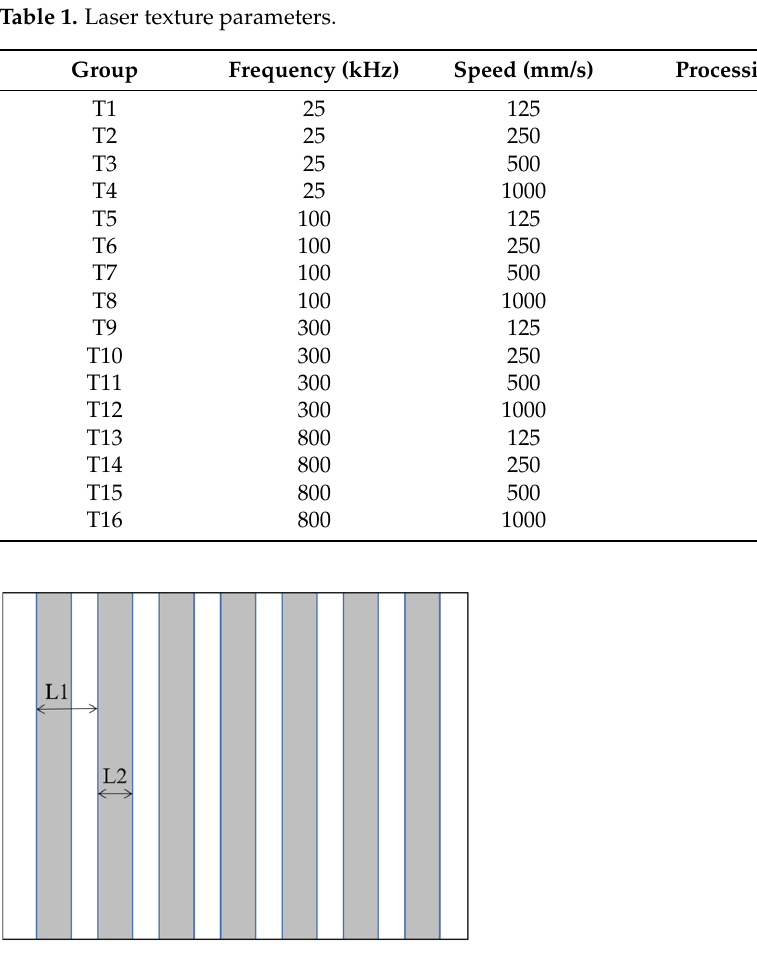
Figure 1. Texture spacing diagram, L1 is the texture spacing and L2 is the width of the machined grooves.